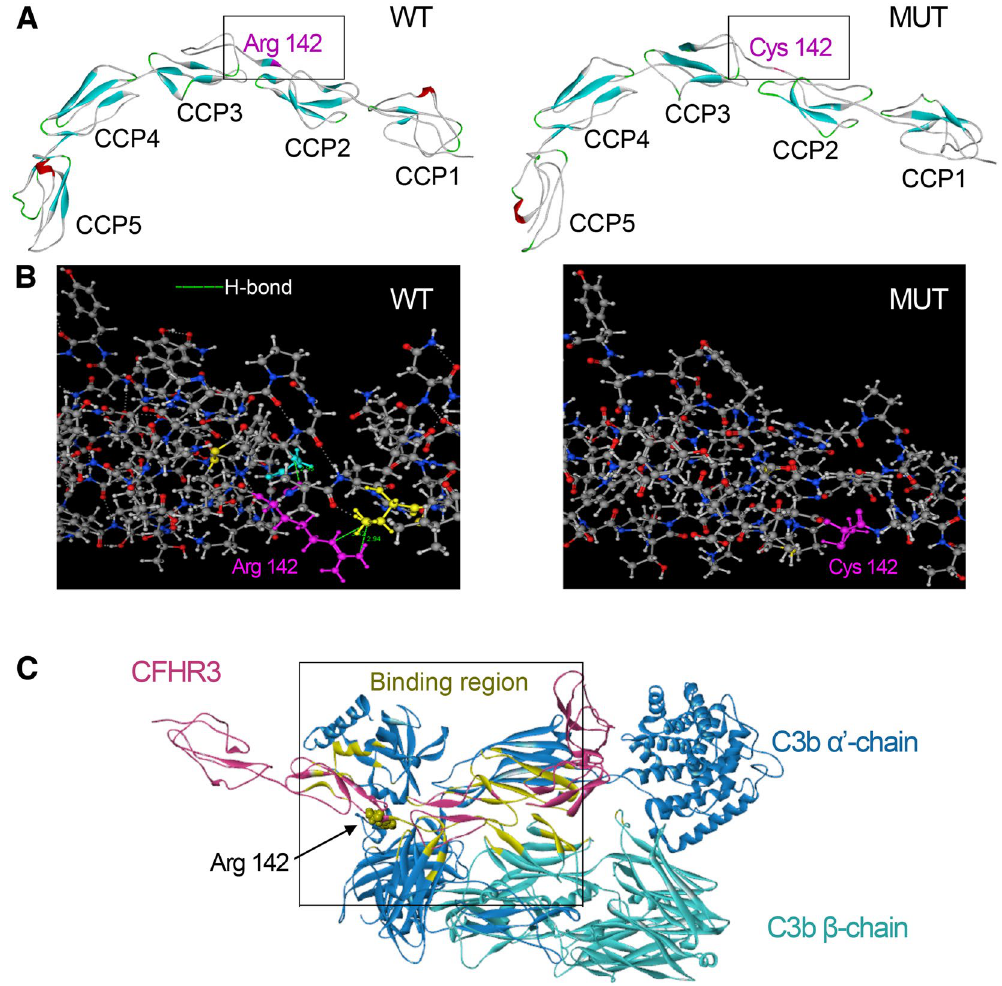
Figure 3. Three-dimensional models of CFHR3 WT , CFHR3 Arg142Cys and CFHR3/C3b complex. ( A ) Models of WT and MUT CFHR3 obtained by homology-modeled and shown with 5 complement control protein modules (CCPs) by DS 3.0. The β -strands are shown in turquoise, а-helices in red, and the loops connecting in WhiteSmoke ™ . The location of the Arg142 and Cys142 is highlighted in orchid. ( B ) Generated models show the discrimination of local intramolecular hydrogen bonding interactions between Arg142 and Cys142 by MOE. Hydrogen bonds are shown with a fluorescent green dotted line representation. ( C ) Structure of CFHR3 in complex with the ligand C3b were generated with the DS 3.0. CFHR3 is denoted by pink; C3b (based on the C3 crystal structure, PDB 2WII) consists of a β -chain (residues 1–642) shown in turquoise and α ’-chain (residues 730–1641) in steel blue. The binding regions of the CFHR3/C3b complex are presented in yellow. The Arg residue 142 of CFHR3 is highlighted with a CPK model and shown to be directly involved in the binding to